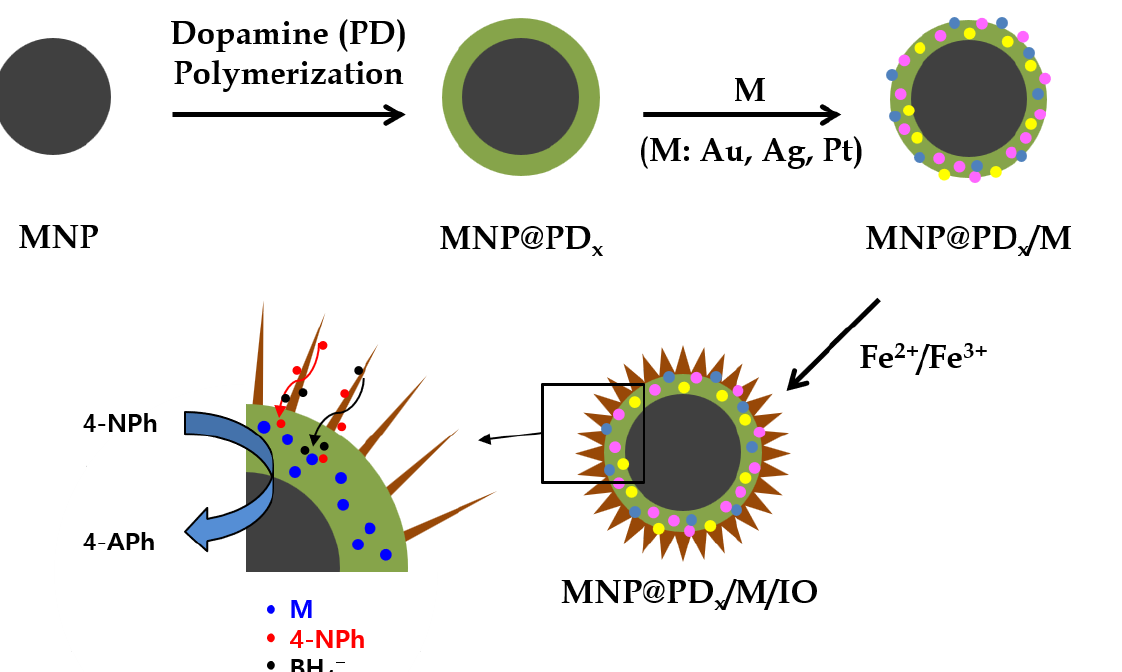
Figure 1. Schematic of the procedure for the preparation of iron oxide nanoneedles with a hierarchical structure by successively depositing layers of polydopamine (PD), metal nanoparticles (M) and iron oxide (IO) on the magnetic nanoparticles (MNPs) and catalytic application for 4-NPh reduction. x represents the thickness of the PD layer in nm (x = 30, 60 and 100).